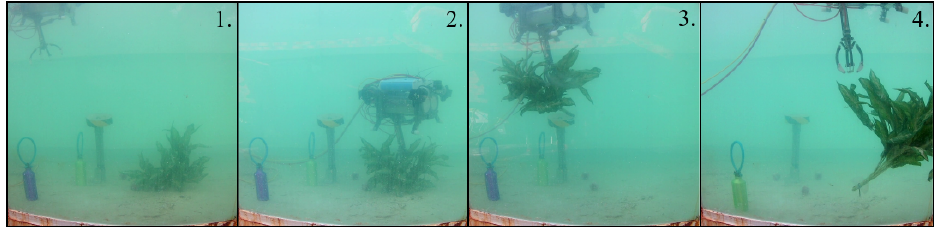
Figure 20. Practical results for catching the plant. The numbers are given according to the proposed stages in the